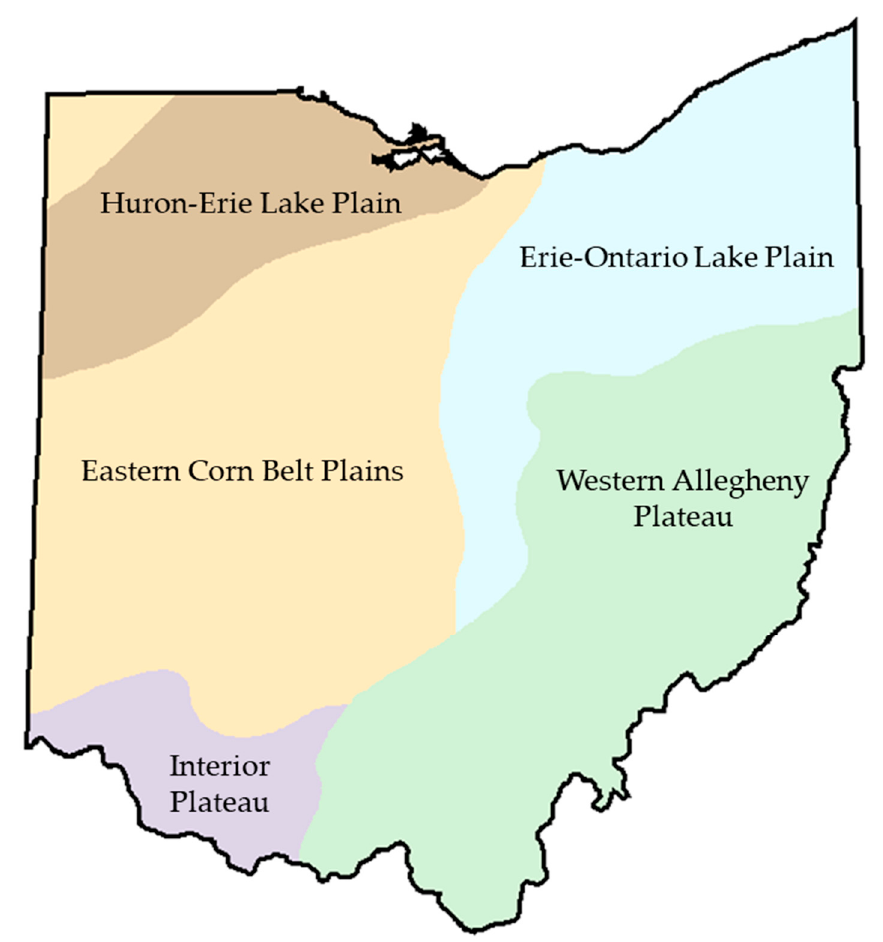
Figure 1. Level III ecoregions of Ohio.